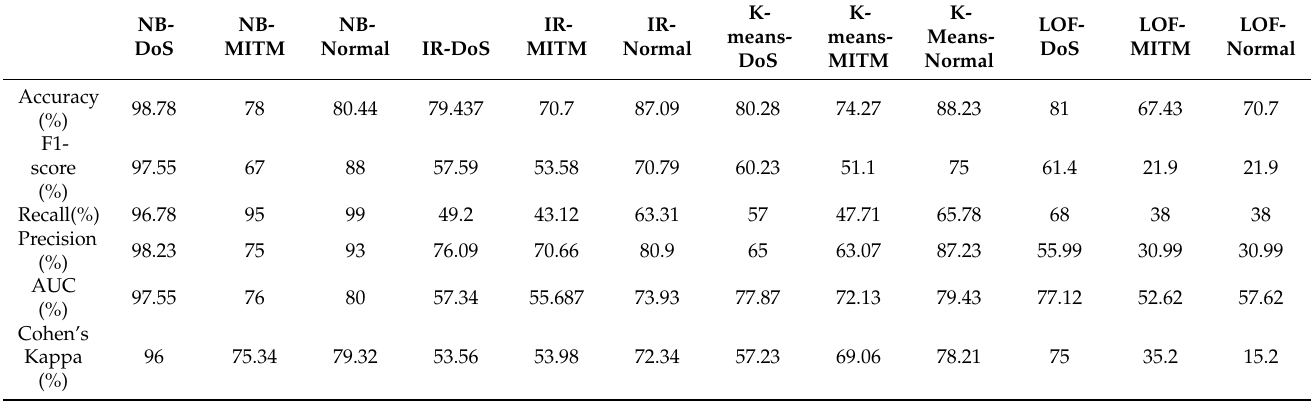
Table 7. Performance analysis of the multiclass classification of the BLE IDS using supervised— ML